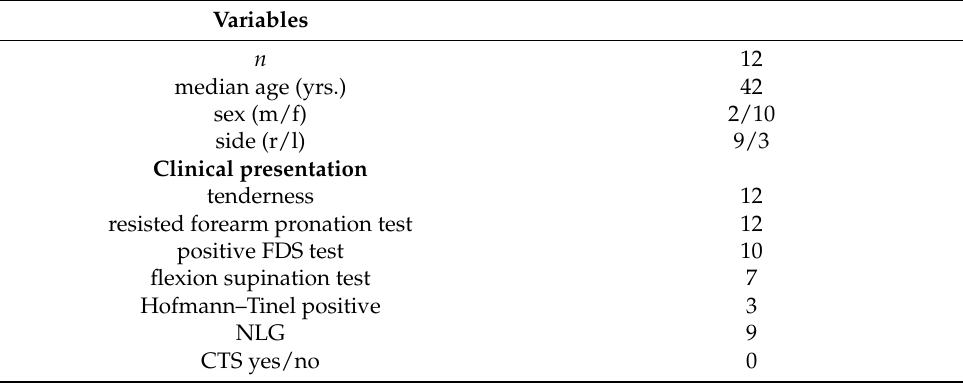
Table 1. Baseline demographics of patients with PTS